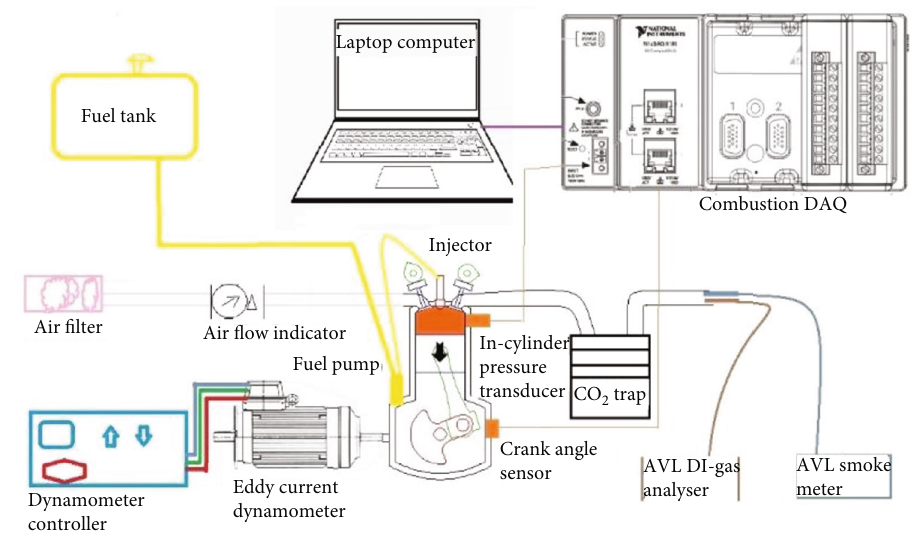
Figure 7: Layout of experimental setup.